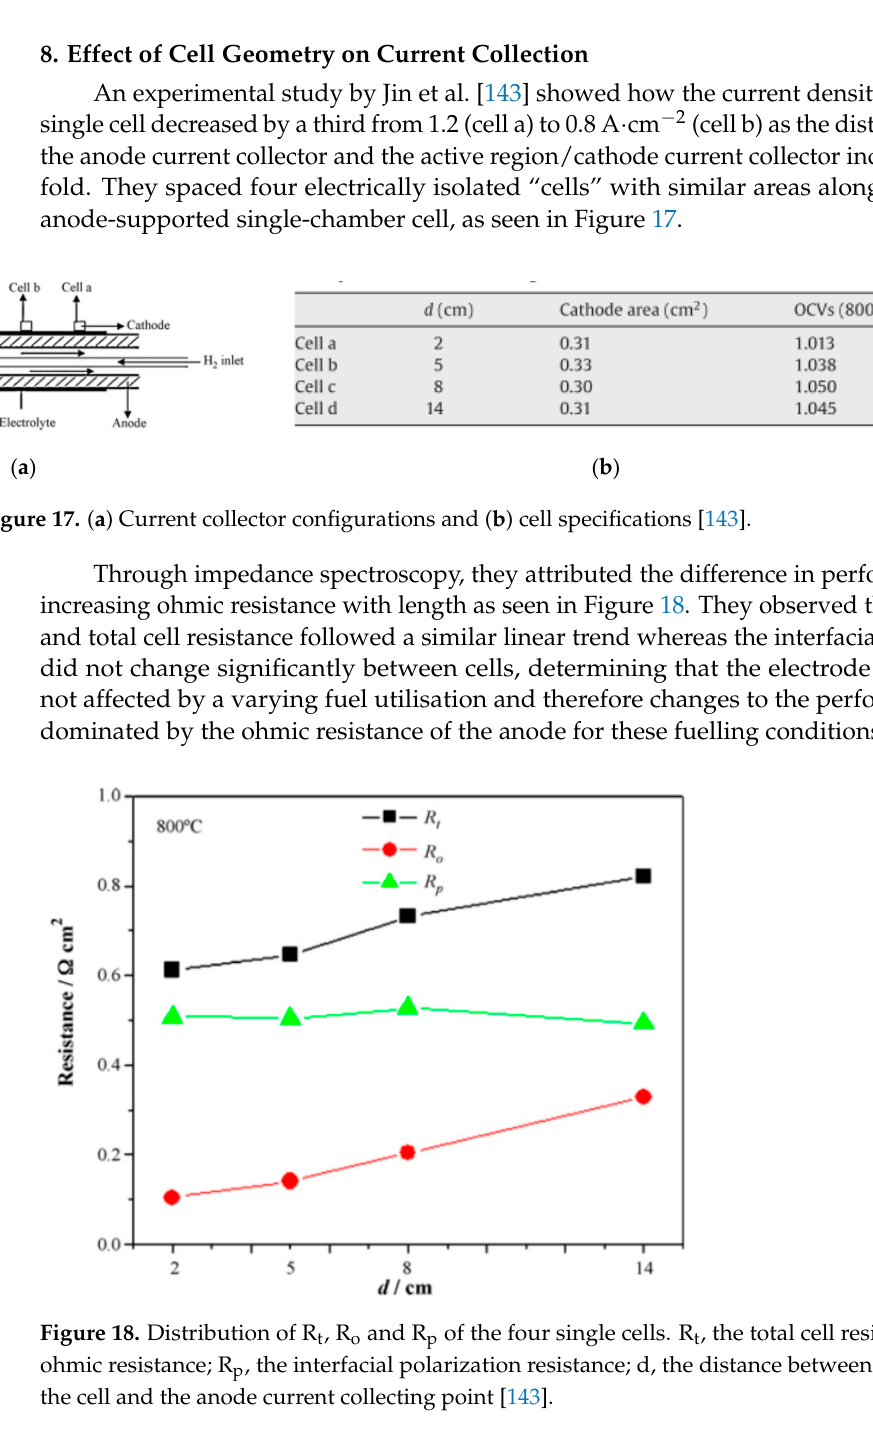
Figure 19. Wall thickness versus area-specific resistance for 12 mm long 0.8 mm OD tube [52].